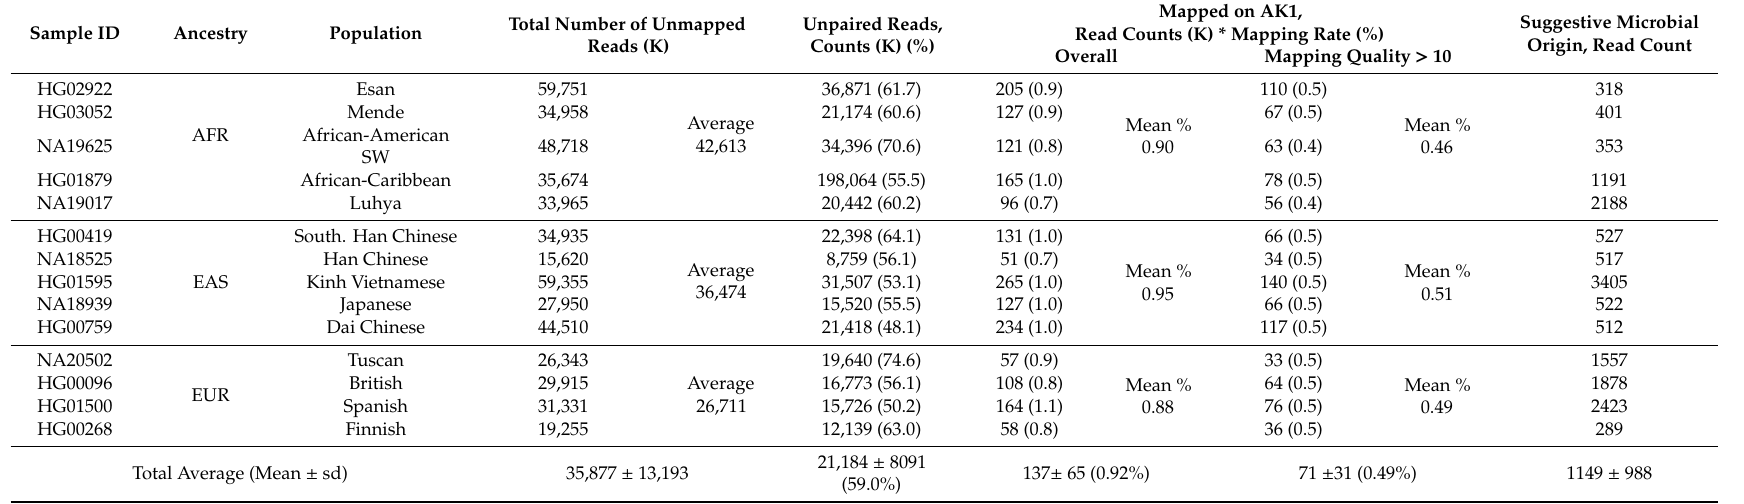
Table 2. The read counts of unmapped reads by